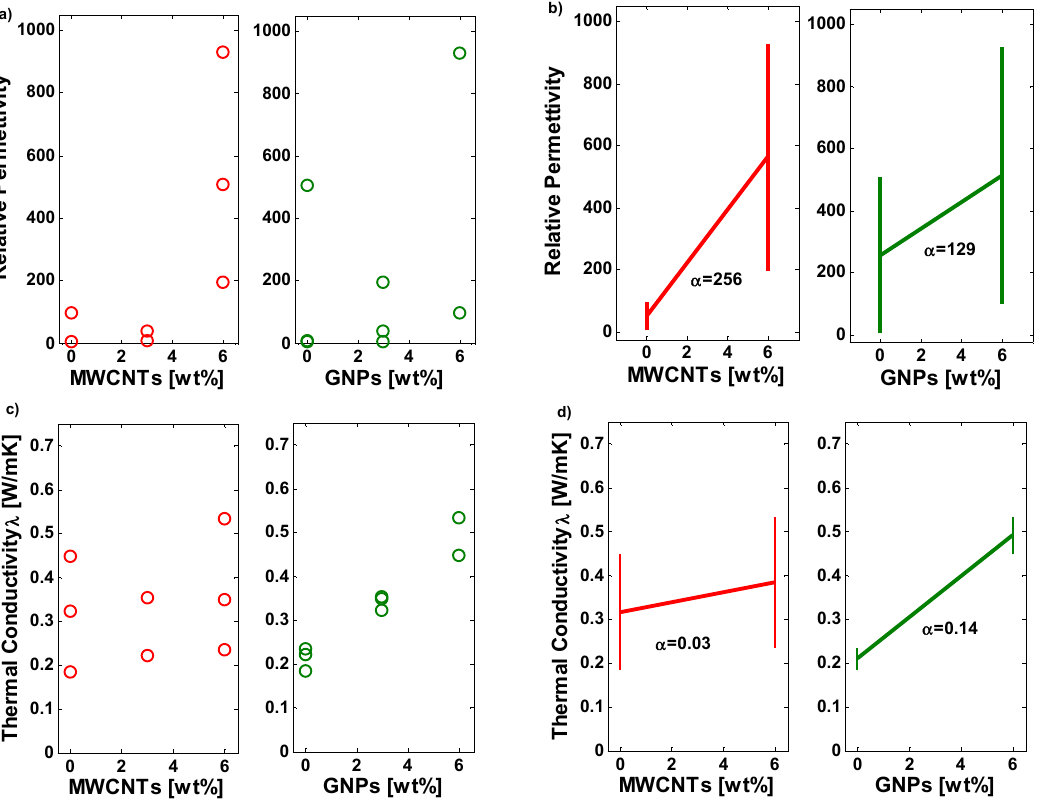
Figure 21. Dex Scatter Plot—DSP and Main Factor Plot—MFP for the experimental data of the relative permittivity in ( a ) and ( b ) and the thermal conductivity in ( c ) and ( d ).